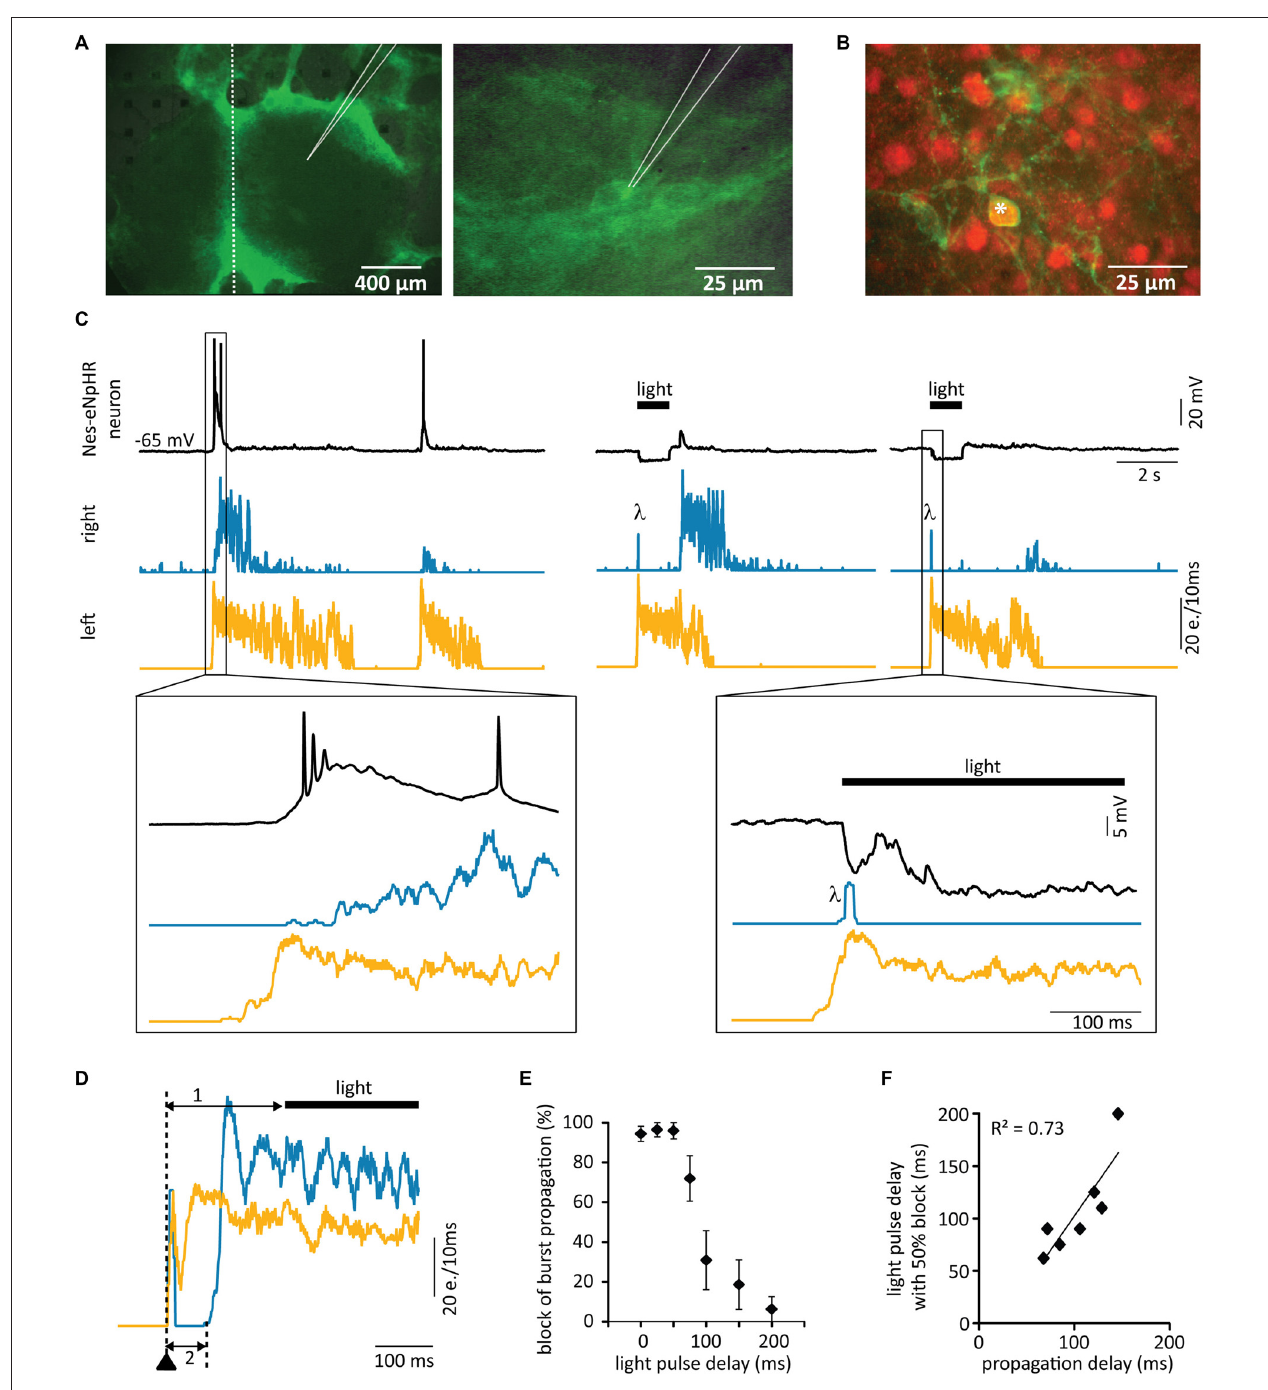
FIGURE 6 | Grafted matured neurons relay network activity. Dissociated fluorescing cells originating from FBs of Nes-eNpHR mice (E14) were transplanted into lesioned rat SC cultures at DIV21. (A) Photomicrographs 3 weeks after the lesion showing the whole culture (left) and a transplanted Nes-eNpHR neuron (right). Location of patch electrode indicated, dotted line represents site of lesion. (B) Labeling against NeuN (red) of Nes-eNpHR-EYFP cells (green) confirms their maturity. Star ( ∗ ) marks double-stained cell. (C) Simultaneous MEA recordings from the SC slices and single-cell patch-clamp recordings from Nes-eNpHR grafted neurons. Left: network activity in the left slice precedes bursting activity in the grafted neuron, which in turn induces activity in the right slice. Right: this strictly unidirectional activity propagation through the grafted neuron acting as a relay between the slices is verified by optogenetic activity suppression in the grafted neuron. Bursting activity in the left slice triggered the switching on of yellow light, preventing activity in the grafted neuron resulting in a lack of activity in the right slice. λ artifacts due to the light onset. (D) Activity induction in the left slice (arrowhead) with an electrode of the MEA. The yellow light pulse was applied 150 ms after stimulation